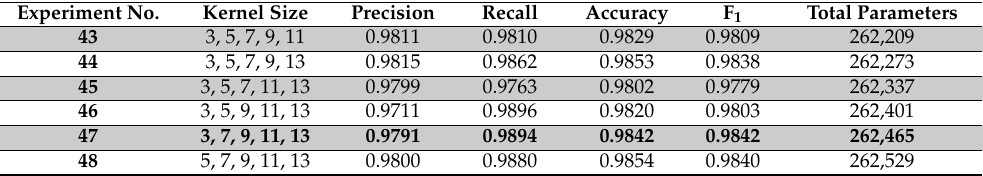
Table 11. Classification performance of the model for five scales with different kernel